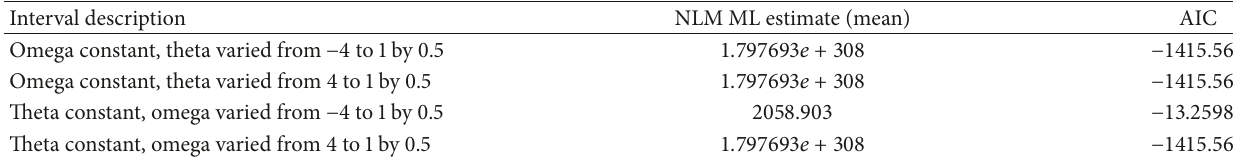
Table 8: Summary of results for lambda = 0.5, 𝑛 = 10 𝑖 , 𝑖 = 4 .